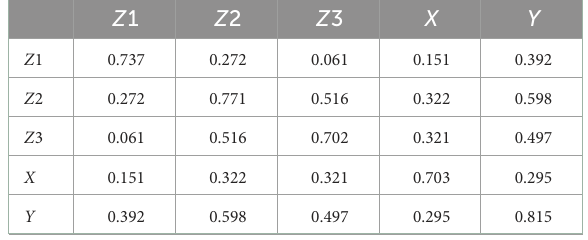
TABLE 3 AVE root and correlation